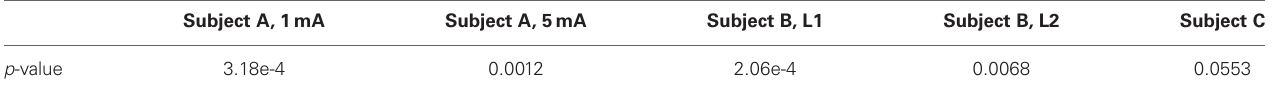
Table 3 | p -values of the Wilcoxon rank sum test of whether integrated information in wakefulness and sleep are